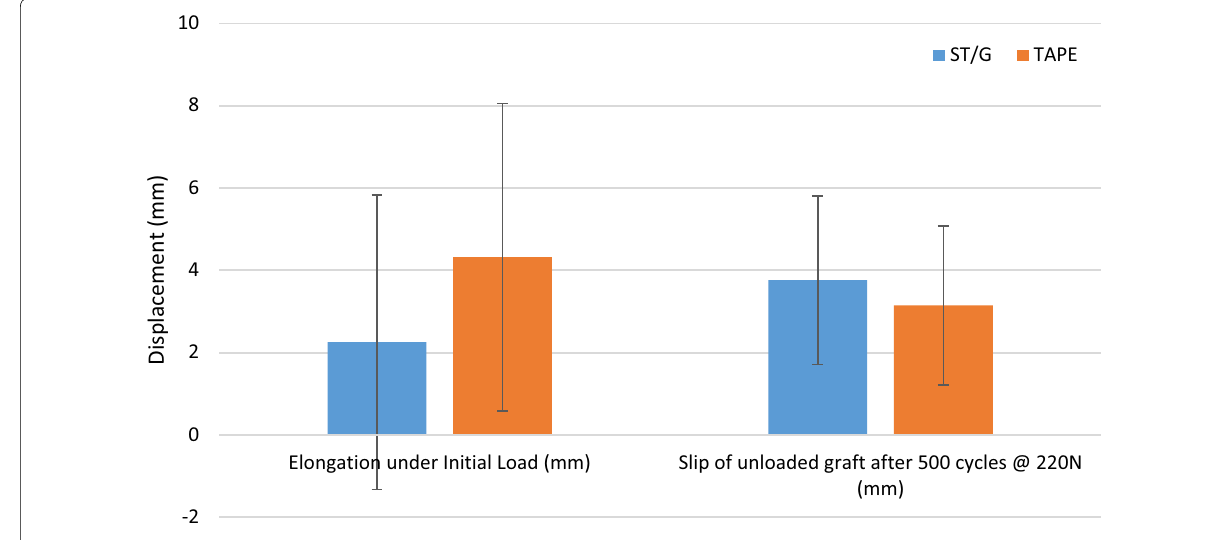
Fig. 8 Results for elongation under initial load and slip of unloaded graft after 500 cycles